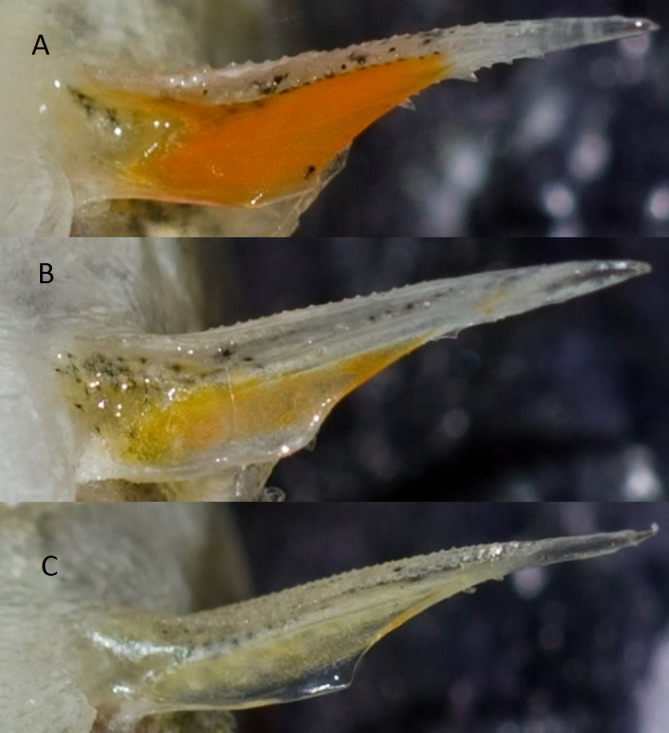
Photos of a pelvic spine from three different sticklebacks.Photo of the right pelvic spine from three different three-spined sticklebacks from site number 10 (see Table 1). An elaborately ornamented male with intensity of red (IR = 0.46) is shown in (A), an intermediately ornamented female (IR = 0.37) is shown in (B), and a drab female (IR = 0.35) is shown in (C). Photos by Jarle Tryti Nordeide.